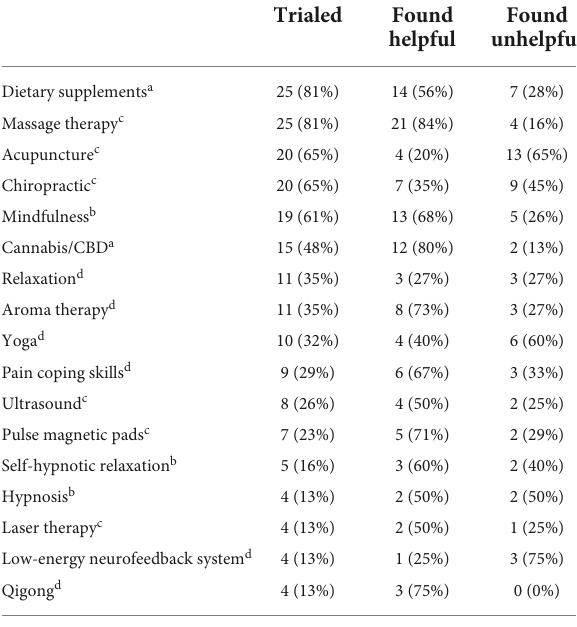
TABLE 4 Complementary and alternative medical (CAM) modalities trialed.